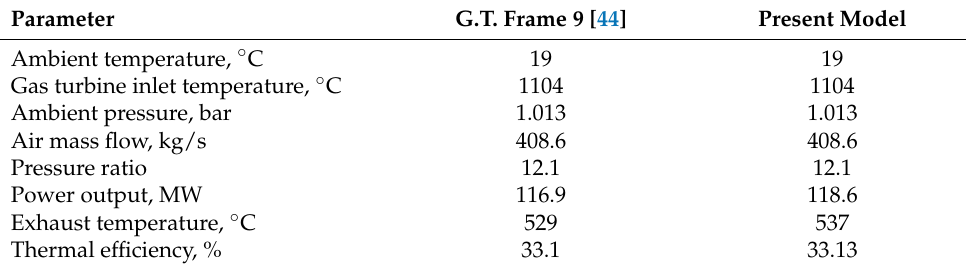
Table 5. Validation of the Brayton cycle